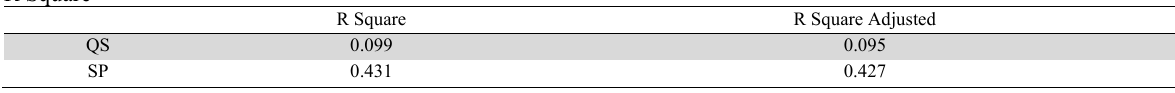
R Square QS 0.099